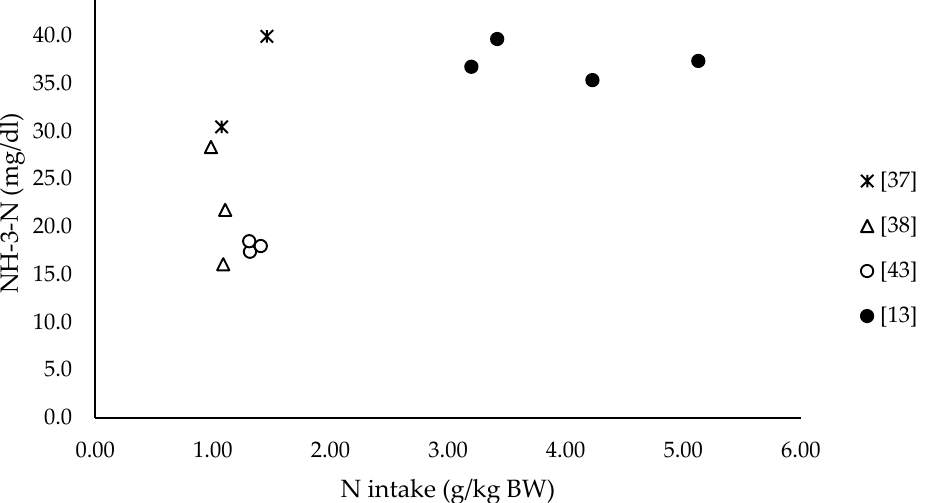
Figure 2. Relationship between N intake and NH 3 -N in lambs fed fresh forage plus feedstuffs (studies plotted measured the intake by difference offered-refused in feeders).